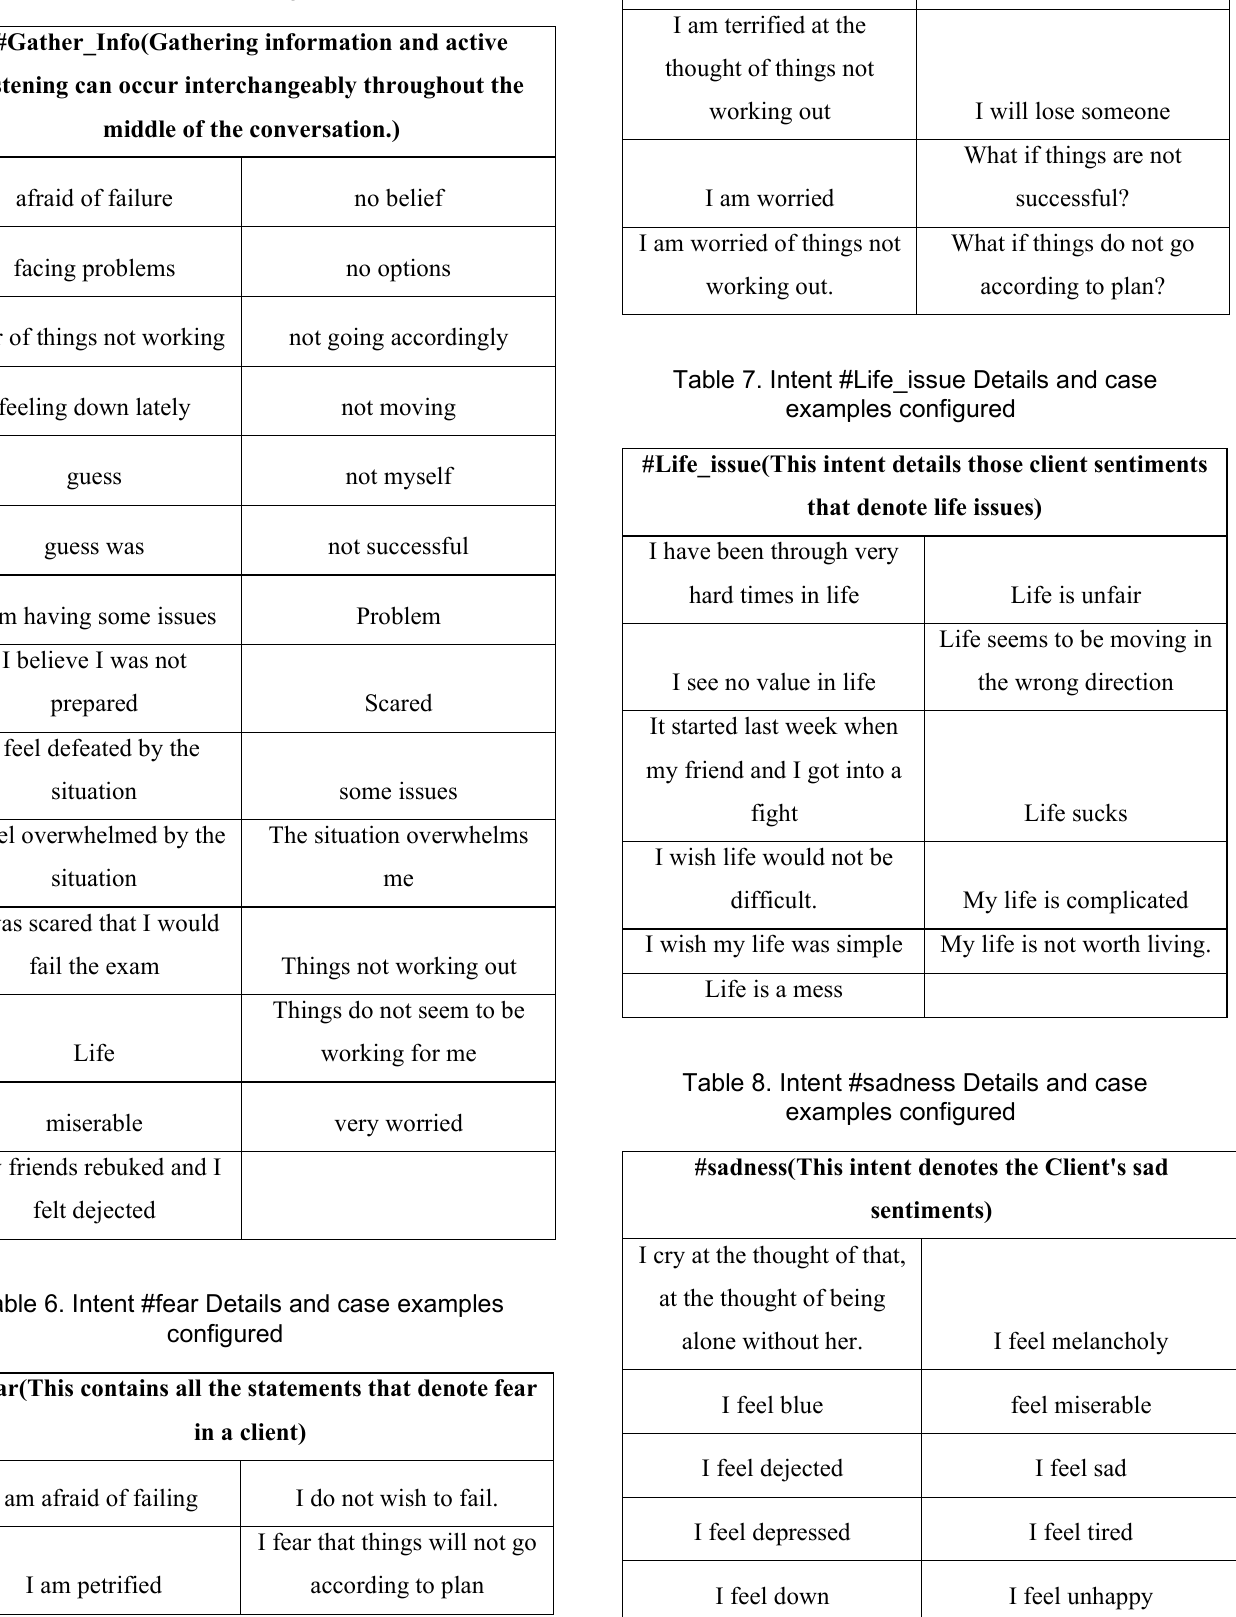
Table 5. Intent #Gather_Info Details and case examples configured